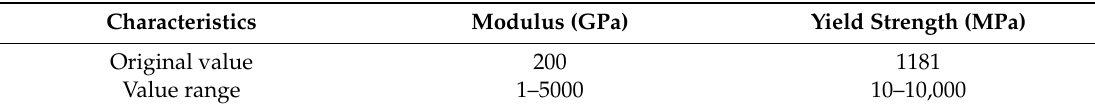
Table 7. Parameters of the di ff erent mechanical supports.